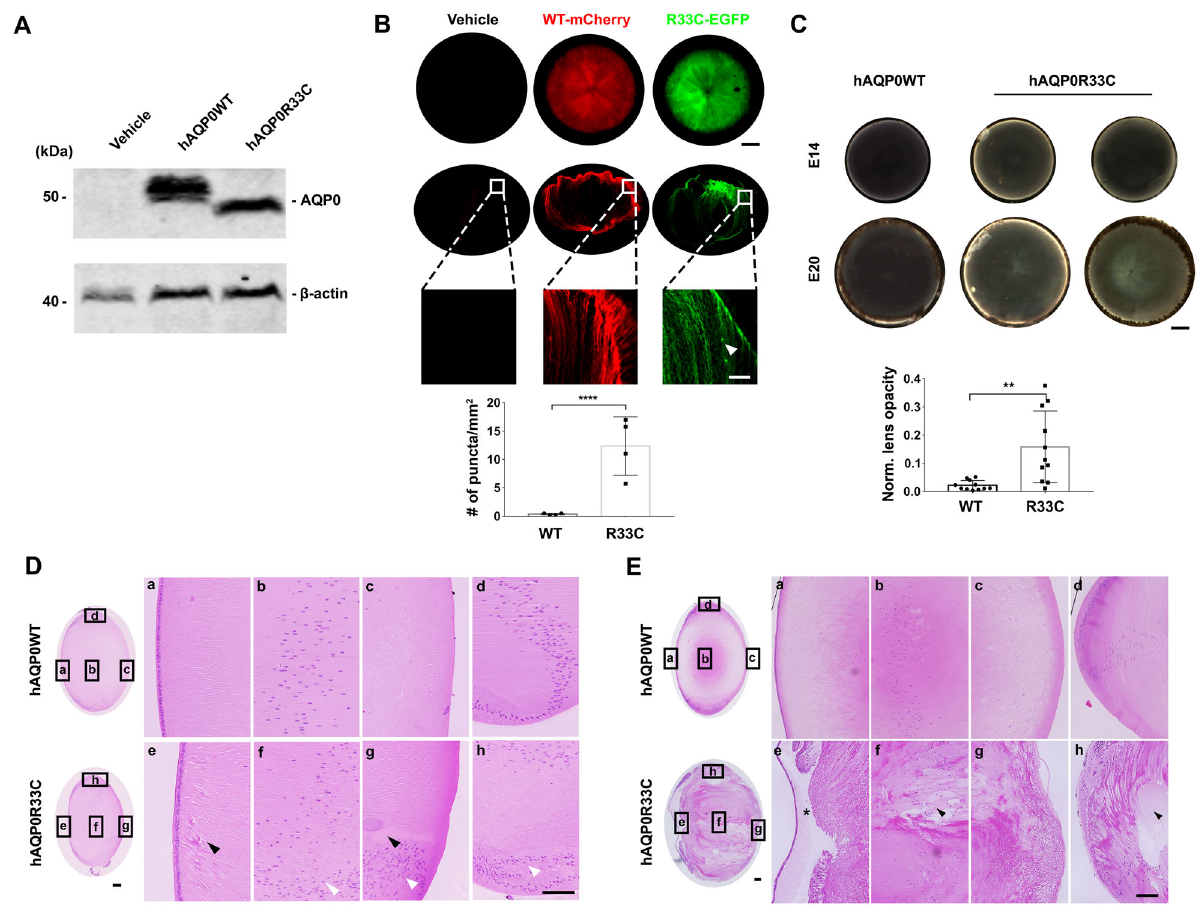
Fig. 6 Exogenous expression of the human AQP0R33C mutation induces cortical cataract formation. Embryonic chick lenses were injected with recombinant RCAS(A) expressing WT hAQP0 or the hAQP0R33C at E14 and E20. A Lysates of E14 chick lenses were prepared and immunoblotted with anti-AQP0 or anti- β -actin antibody. B E20 chick lenses were observed under a fl uorescence microscope for AQP0WT-mcherry (red) and AQP0R33C- EGFP (green) expression in the whole lens, respectively (coronal orientations, upper panels). Frozen sections of the same lenses were prepared and fl uorescence images were taken (middle panels for the whole lens, and lower panels for partial lens indicated with white box) and puncta numbers were quanti fi ed (bottom panel). For each group, n = 4. Scale bar: 400 µ m for the upper two rows of panels. Scale bar: 50 µ m for the bottom panel. C Opacity of E14 and E20 chick lenses expressing endogenous hAQP0 or hAQP0R33C mutations were shown by light transmission microscopy (upper panel) and quanti fi ed using the same method as described in Fig. 3B (bottom panel). For each group, n = 11. Scale bar: 400 µ m. Sagittal paraf fi n sections of E14 ( D ) and E20 ( E ) chick lenses expressing WT hAQP0 or hAQP0R33C mutations were prepared and stained with H&E. Black arrowheads show empty and enlarged extracellular spaces. White arrowheads show abnormal nuclear distribution. Black asterisk points to a detachment region between epithelial and fi ber cells. Scale bar, 50 µ m. All data are presented as mean ± SEM. ** P < 0.01, **** P < 0.0001. n =